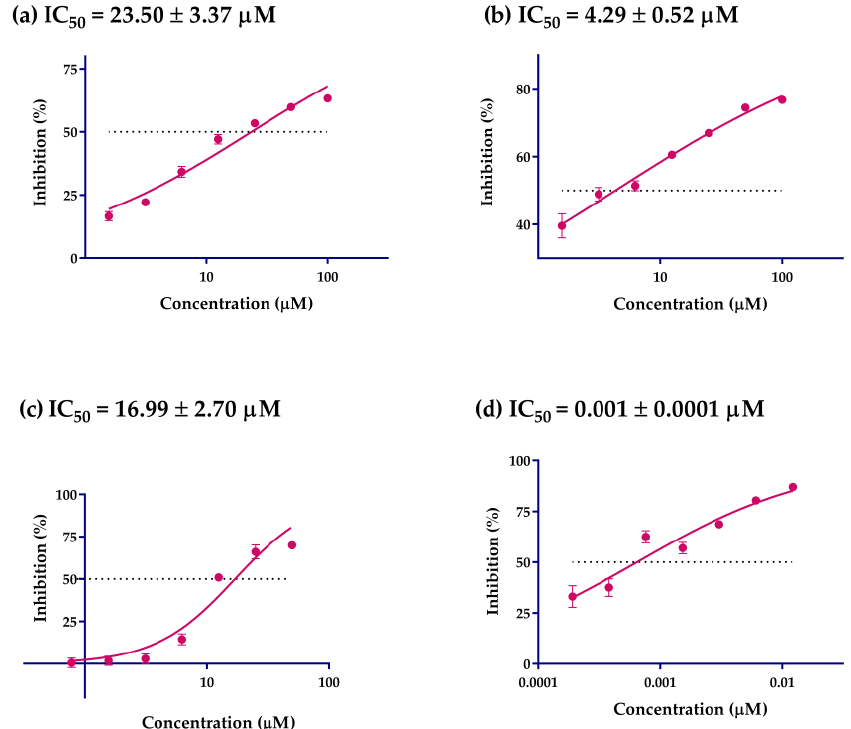
Figure 6. α -Glucosidase inhibitory effects of compounds 3 , 9 , and 13 . ( a ) Log concentration–inhibition rate fitting curve of compound 3 . ( b ) Log concentration–inhibition rate fitting curve of compound 9 . ( c ) Log concentration–inhibition rate fitting curve of compound 13 . ( d ) Log concentration–inhibition rate fitting curve of acarbose. Calculated IC 50 values of different groups by Statistical Product and Service Solutions (SPSS, version: 21.0), and all values are mean ± SD from a least three independent experiments.